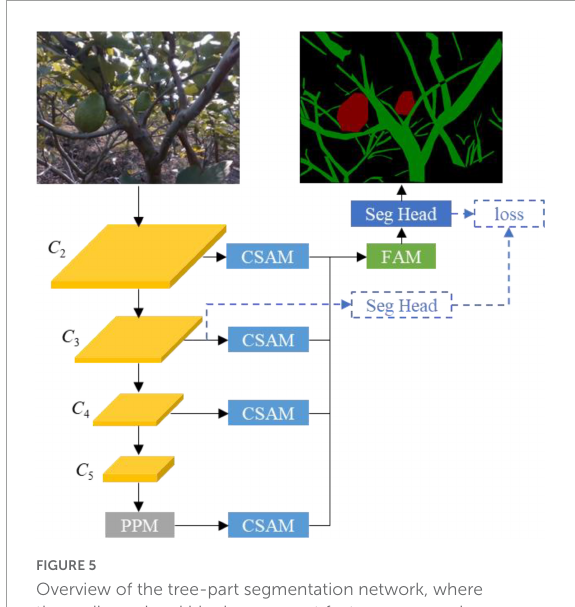
FIGURE5 Overview of the tree-part segmentation network, where three-dimensional blocks represent feature maps and two-dimensional blocks refer to convolutional modules.